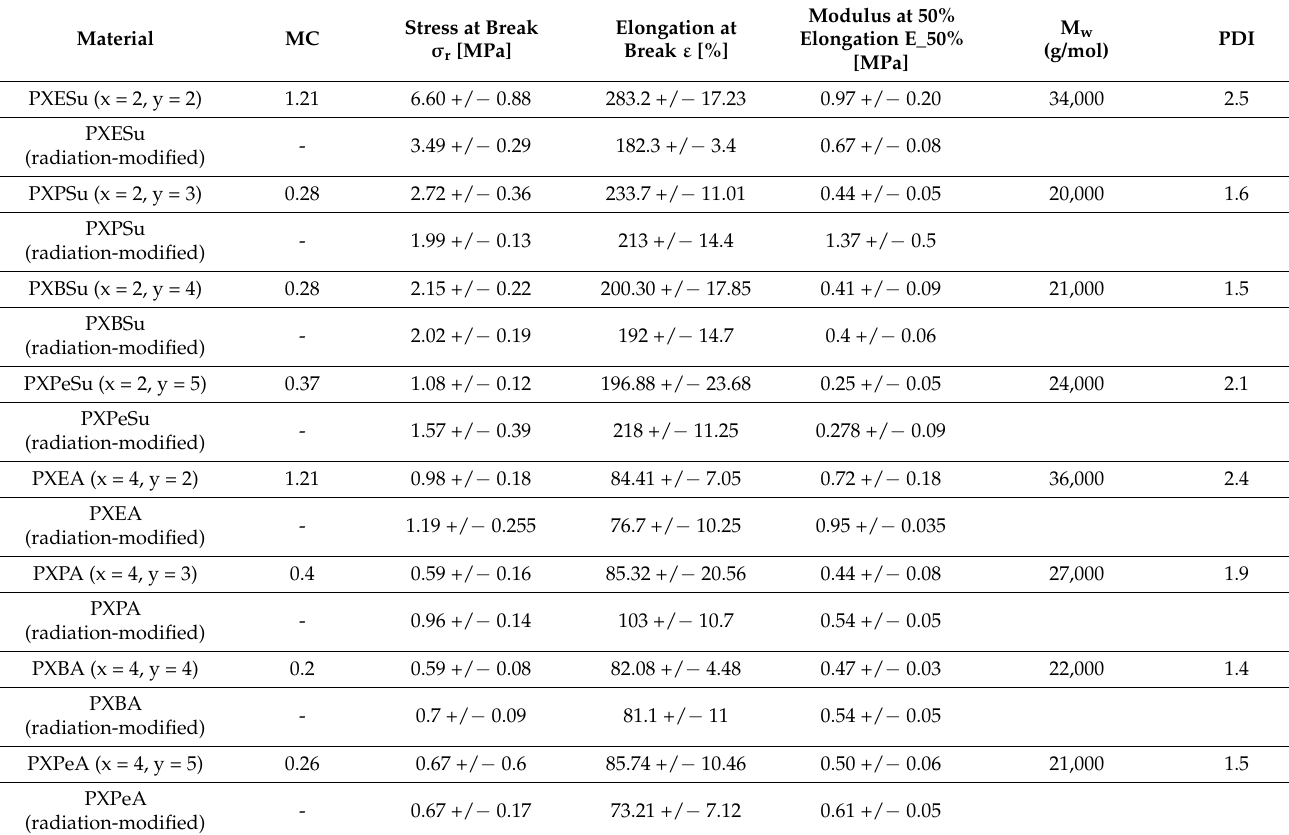
Table 1. Composition and selected properties of poly (xylitol dicarboxylate-co-diol dicarboxylate) before and after irradiation.